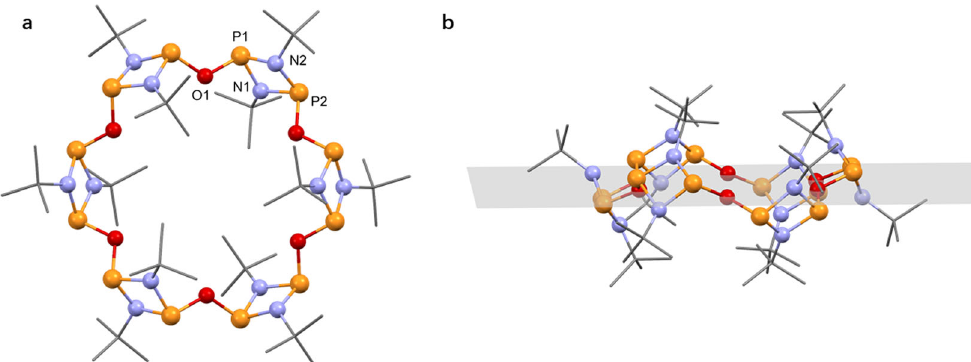
Fig. 5 Hexameric cyclophosphazane macrocycle (7). Solid-state structures of 7 . a Top view of compound 7 . b Side view of compound 7 including the plane de fi ned by all the oxygen bridging atoms. The tert-butyl units are drawn as wireframes in all the graphical representations. H atoms are omitted for clarity. For thermal ellipsoid representation, selected bond lengths, and angles see Supplementary